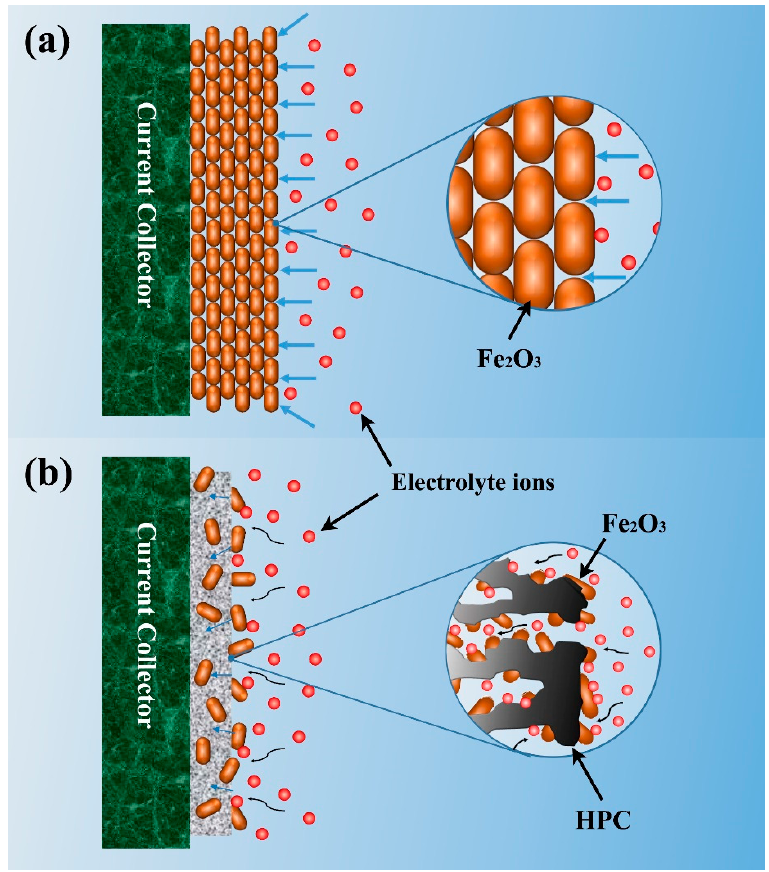
Figure 6. Effect of HPC substrate on the capacitance of composite electrode.